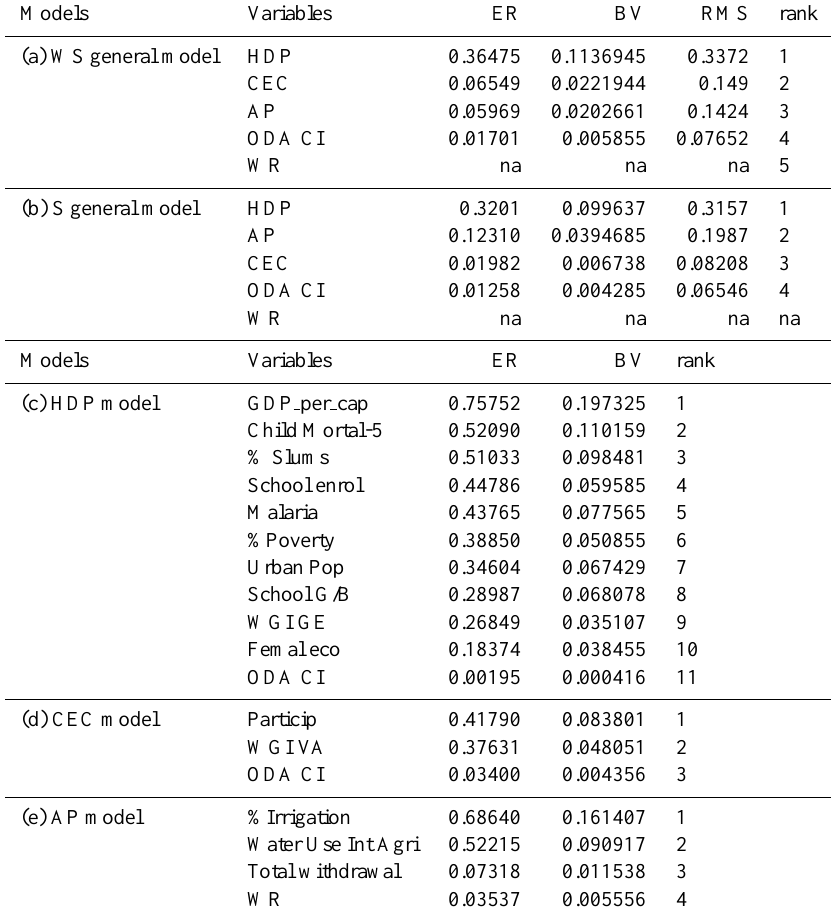
Table B1. Sensitivity analysis results by